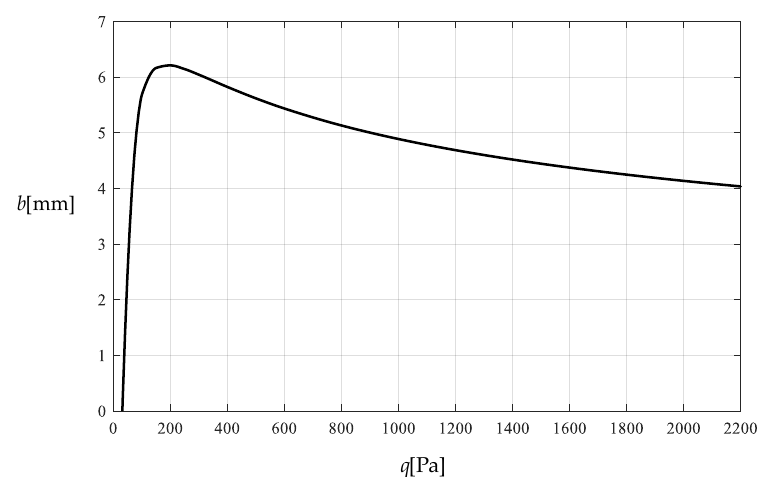
Figure 14. Variation of b with q .